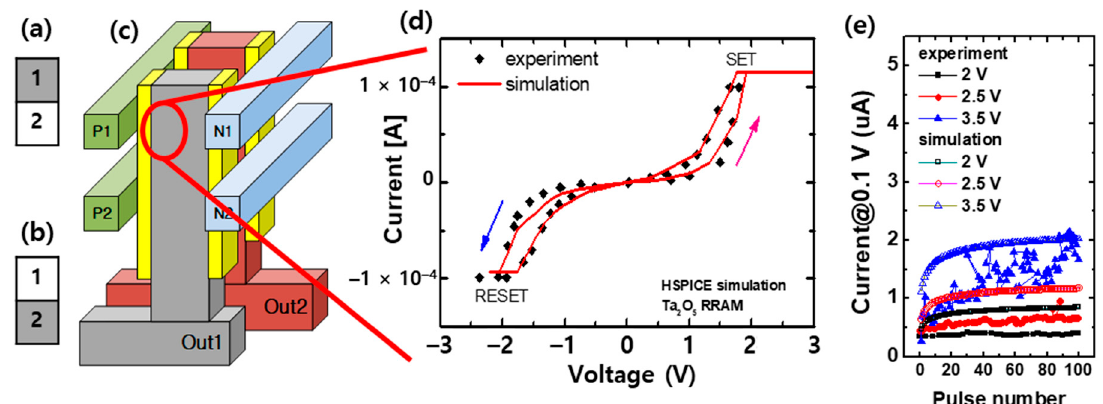
Figure 4. A two-pixel image where ( a ) pixel 1 is black and Out1 is “1”; ( b ) pixel 2 is black and Out2 is “1”; ( c ) 3D VRRAM synapse for a two-pixel image; ( d ) nonlinear I-V characteristic; and ( e ) linearly modulated potentiation behaviors of the Ta 2 O 5 memristor device [21].